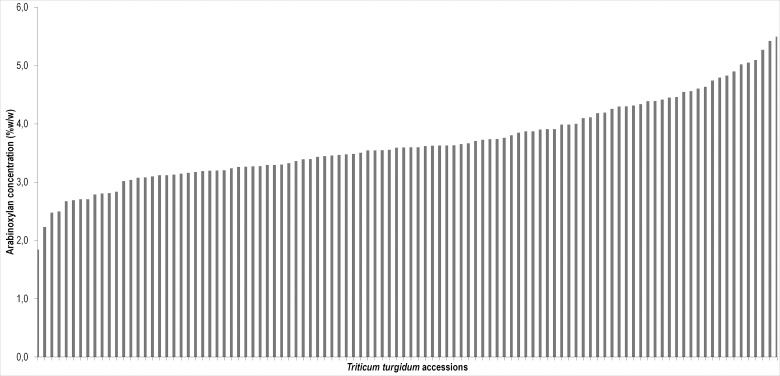
Arabinoxylan content evaluated in a collection of 104 Triticum turgidum genotypes.The reported values are the mean of three biological replicates grown at Valenzano 2012.